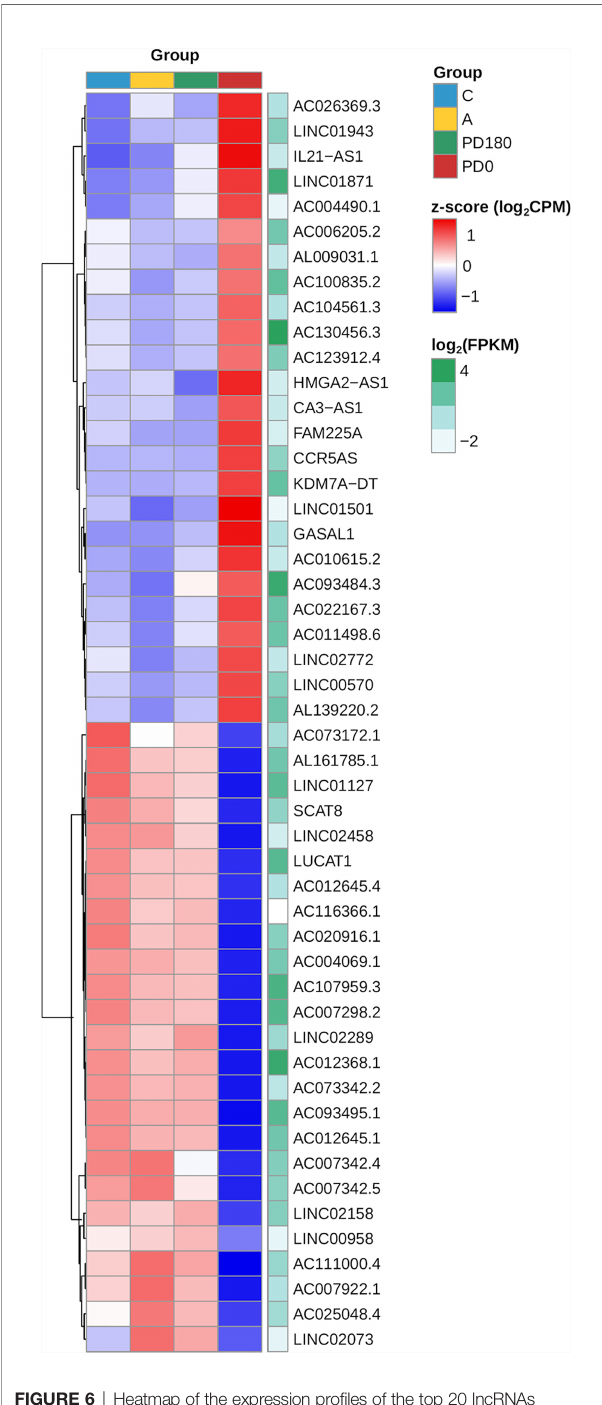
FIGURE 6 | Heatmap of the expression pro fi les of the top 20 lncRNAs expressed in VL patients (PD0). The top selection retrieved those genes within the dataset of 147 primarily selected DE lncRNAs ( Supplementary Table 2 ) based on ranking of statistical signi fi cance (FDR values) followed by fold regulation (log 2 FC values). Gene expression regulation by group is represented by the z score of the cpm read count, and the transition color scale from red to blue indicates up- and downregulation, respectively. Gene expression level is represented by mean FPKM values at the side (green heatmap column), where color intensity toward dark green indicates increasing levels (highly expressed